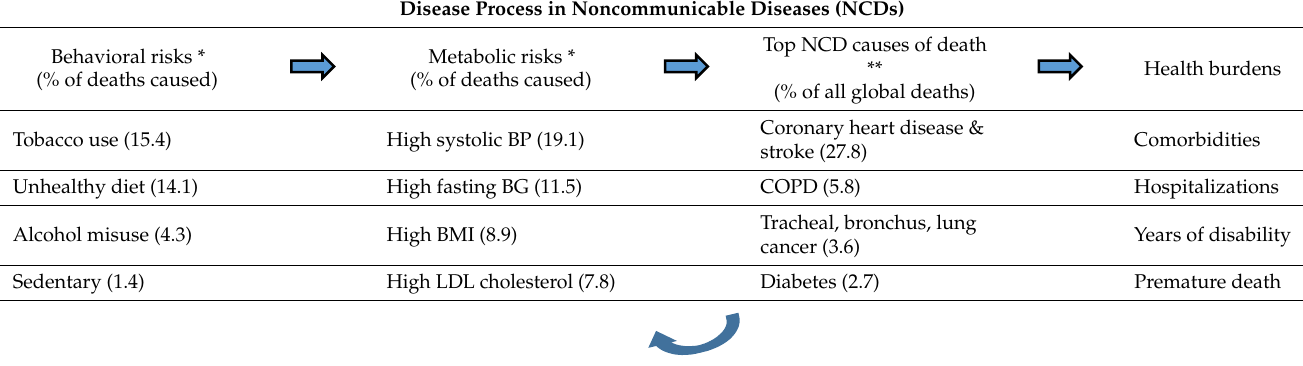
Table 1. Percent (%) of global deaths in 2019 attributable to the 4 behavioral and 4 metabolic risk factors responsible for the global epidemic and burdens of NCDs.